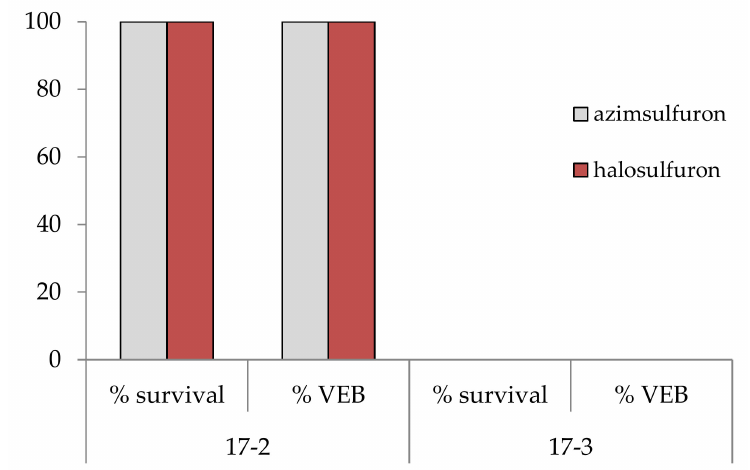
Figure 1. Whole plant bioassay conducted on Cyperus esculentus populations (17-2 and 17-3 at Legnaro (North Italy) in autumn 2017. Percentage of plant survival and visual estimation biomass (VEB) four weeks after treatment with two ALS-inhibiting herbicides applied in